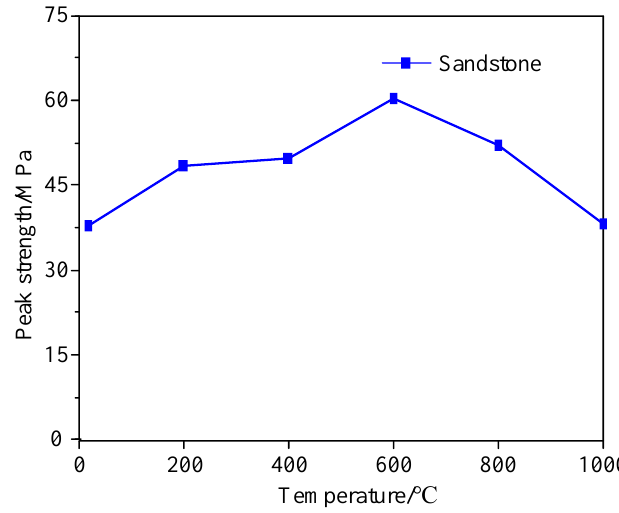
Figure 5. Variation curve of sandstone peak strength with temperature.